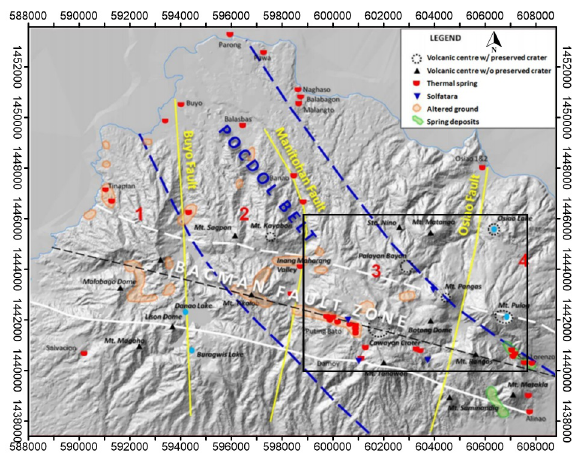
Fig. 3. An isoresistivity map at a depth of -1100 m from MSL which is correlated with the geological structure in Fig. 2. Structure and manifestations at the Bac-Man the area, shows that the central part of the Bac-Man fault geothermal field [2] zone has a low resistivity value